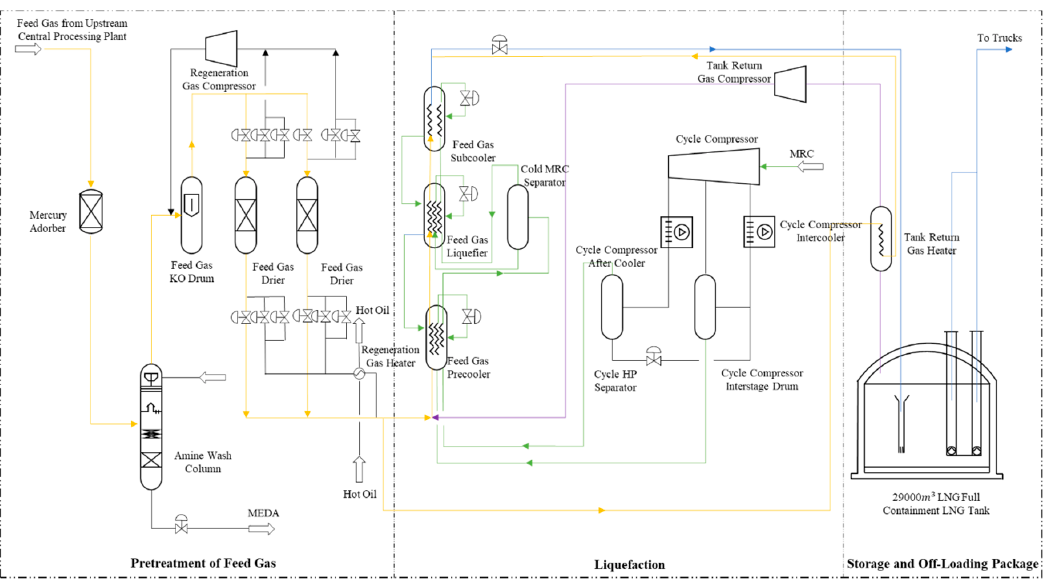
Figure 3. Flow chart of the natural gas liquefaction process.